Question: In one sentence, what is this figure communicating?
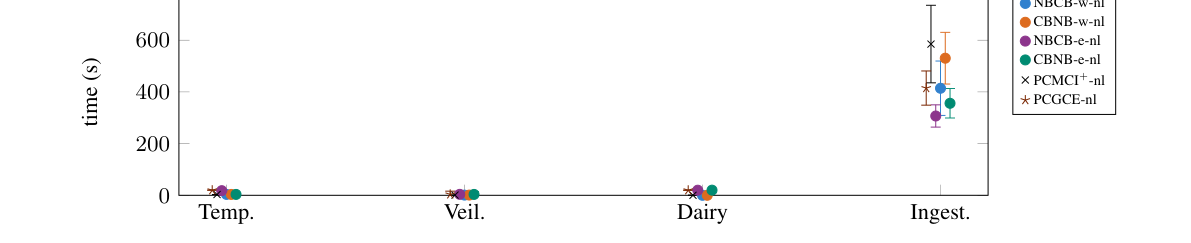
Answer: Time computation (in second) for NBCB-w, CBNB-w, NBCB-e, CBNB-e, PCMCI+, and PCGCE for real datasets of Section 5.4. We report the mean and the standard deviation.